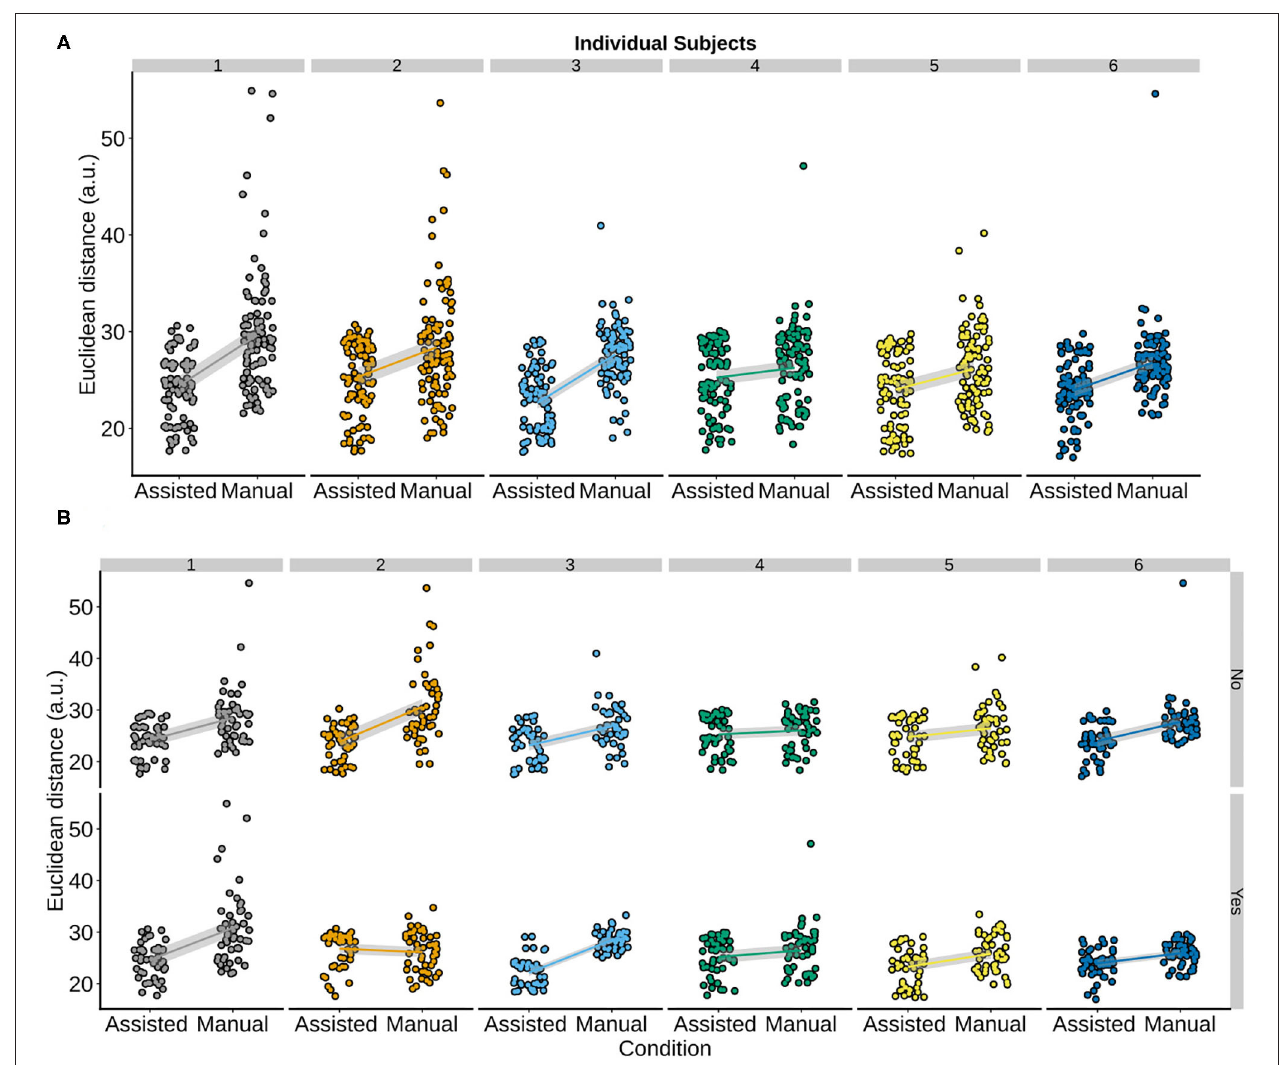
FIGURE 5 | Raw data separated by subject with overlaid regression lines and shaded SEs for the assisted vs. manual condition. The y-axis shows accuracy for all trials for each subject individually. A positive slope from the assisted to manual condition means that the controller improved the accuracy of the subjects. A positive slope can be observed for all subjects in panel (A) data were collapsed across the switch and the no switch condition. Similarly, when the data was split according to the switch and no switch condition, a positive slope can be observed for all subjects and conditions in (B) , except for the bottom row of the second